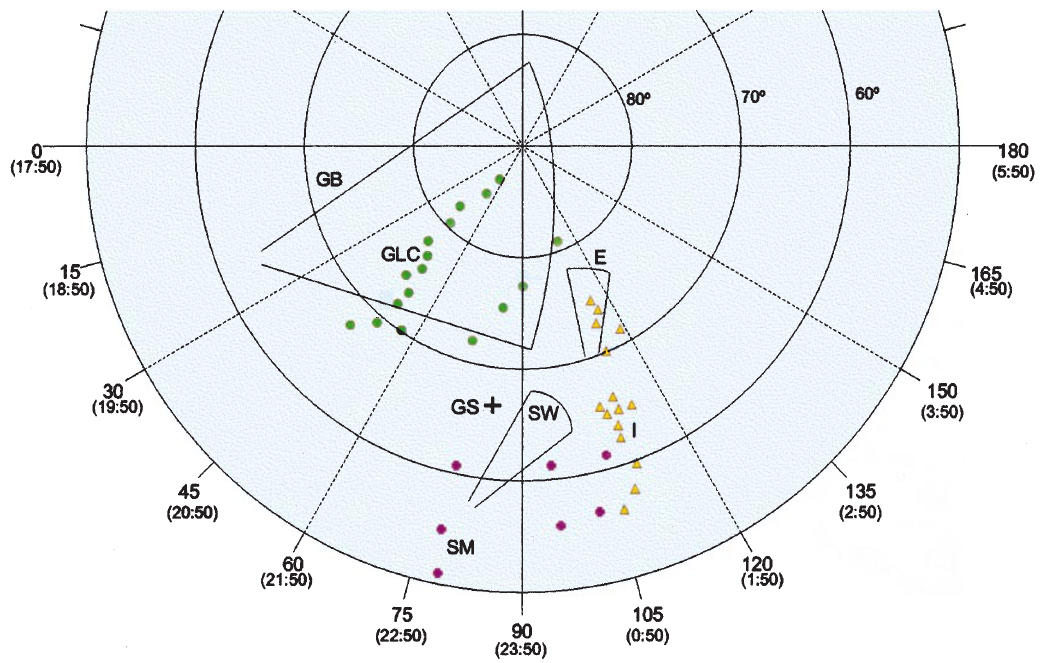
Wick SW . The solid circles represent the positions of the magnetometers in the Greenland Chain ( GLC ), IMAGE ( I ) and SAMNET ( SM ) networks respectively. The black cross and the letters GS indicate the magnetic footprint of the geosynchronous